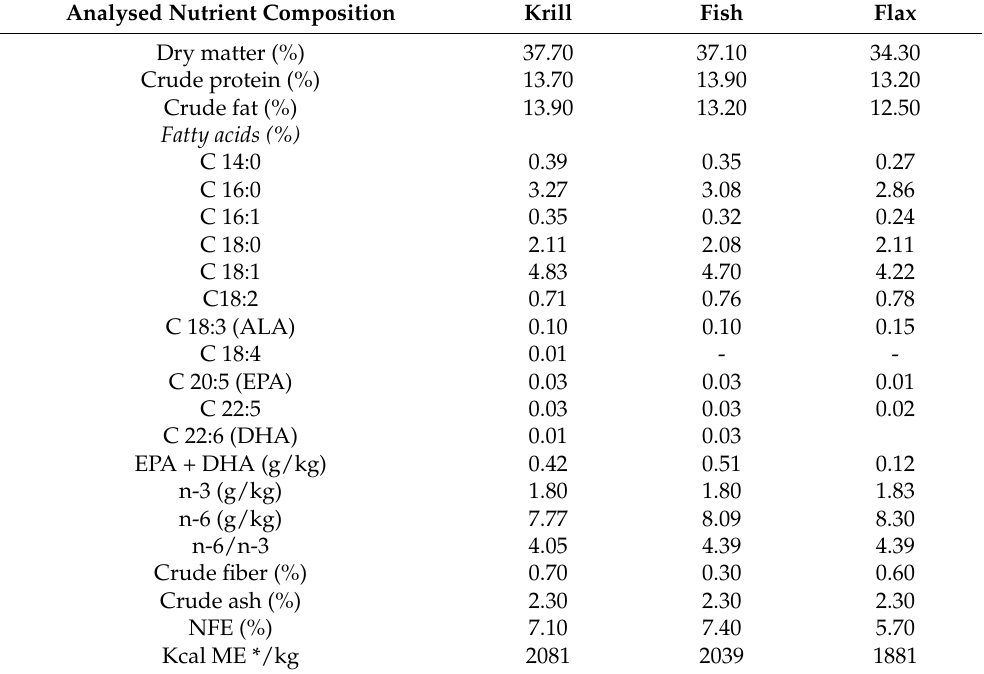
Table 3. Analysed nutritional composition of the three treatment diets as fed. Analysed Nutrient Composition